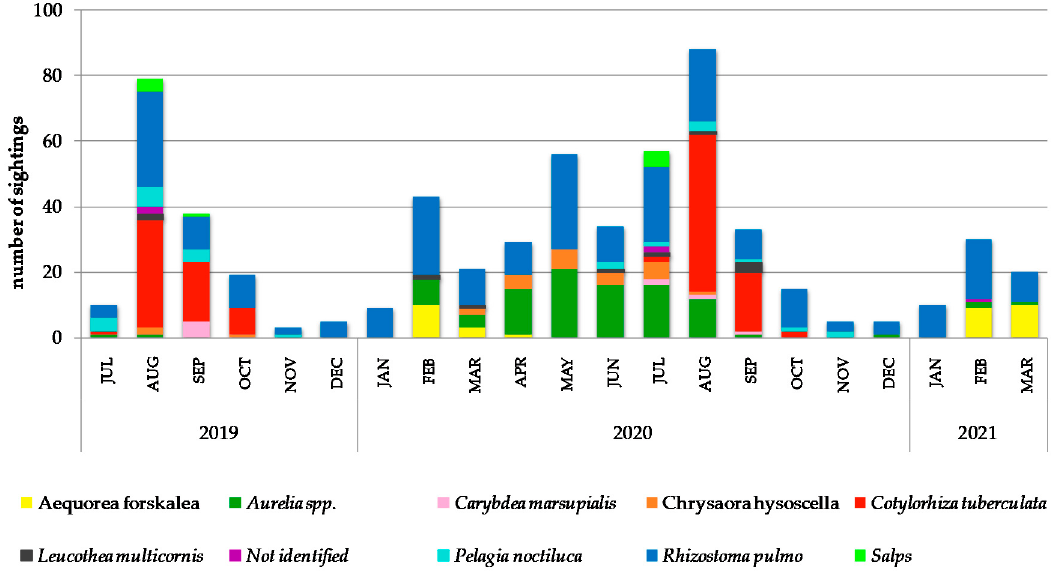
Figure 9. Sightings per month for reported gelatinous taxa other than Mnemiopsis . Both R. pulmo and C. tuberculata were observed more frequently in the Adriatic Sea (Figure 10a,b) within the abundance range of 1 ind. m − 2 , but R. pulmo was also observed